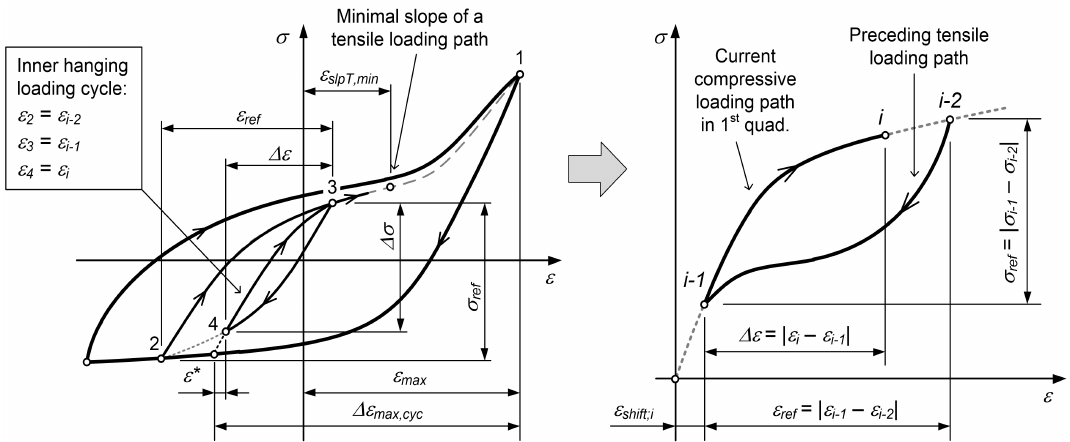
Figure 5. Modelling the compressive loading path that originates from the inner tensile loading